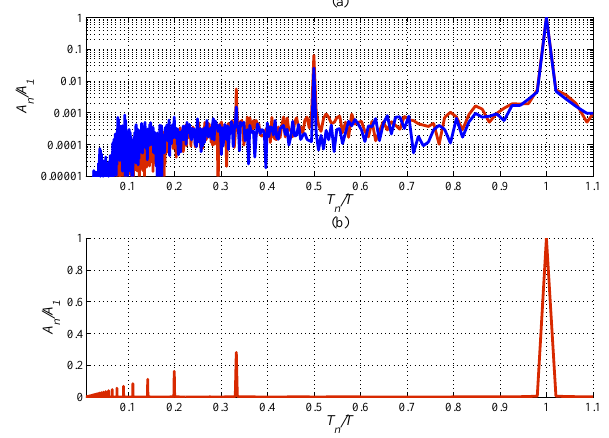
Figure 5. Same figure as Fig. 2 in the manuscript except the varia- tion of D m is over more cycles to generate more points for a reliable return map analysis. Weak Gaussian white noise of standard devia- tion 0.01 is added to the system. Parameters are set to D a = 1 / 2 and D m is varied linearly with time between − 2 and 2 over about 100 cycles. In the upper panel the black lines are the nullclines while the system response is the blue line for T = π giving ωτ ∼ 1 whereas the red line has a shorter period of T = 1 / 4 to give ωτ ∼ 4 π . These are plotted against D ( t ). In the lower panel we have plotted these system responses as time series against the forcing (black